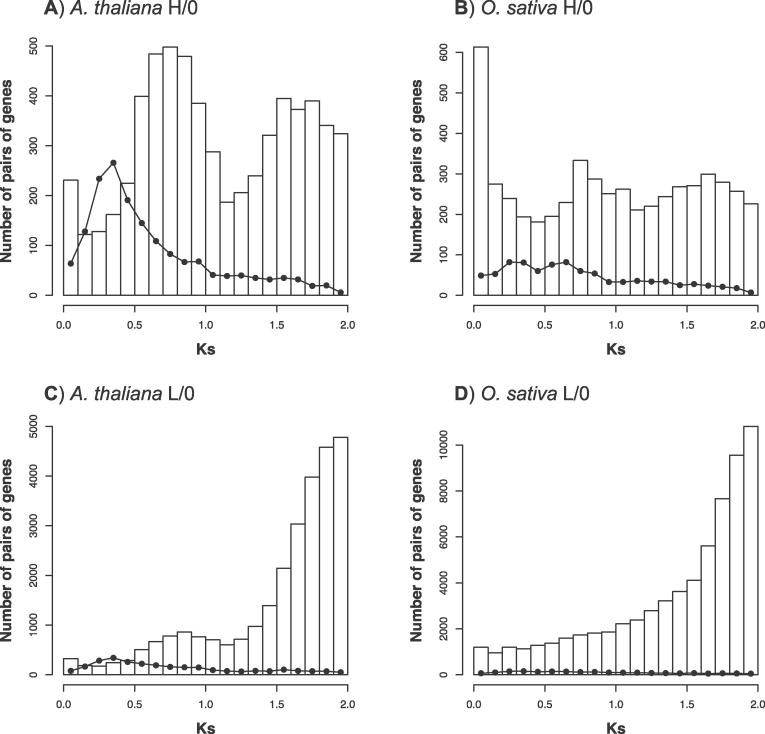
Distribution of Ks Values between TAG Pairs and between Duplicated Non-TAG Gene PairsHistogram of the distribution of Ks values for TAG pairs (dots) and duplicated non-TAG gene pairs (bars) in Arabidopsis and in rice for the H/0 dataset are in panels (A) and (B), respectively. Results for the L/0 dataset are provided in panels (C) and (D).